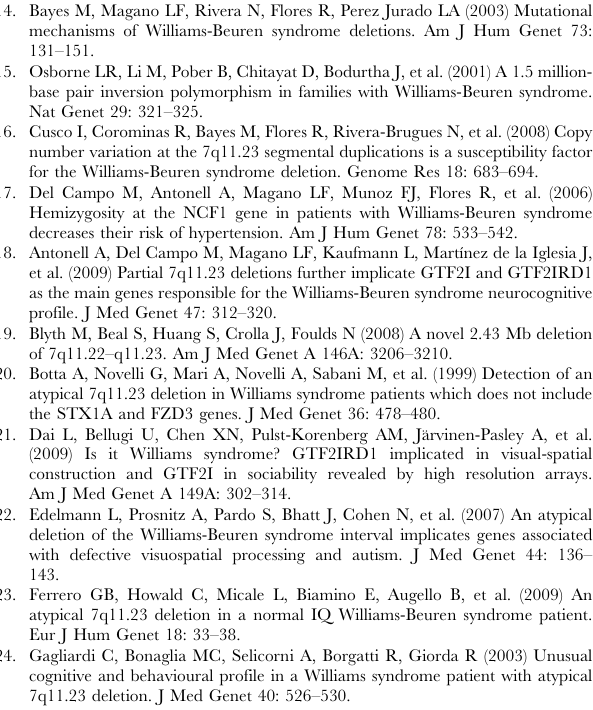
Table S6 GO/KEGG term enrichment in dysregulated M1 modules. Table S7 Dysregulated modules, M2. Table S8 GO/KEGG term enrichment in dysregulated M2 modules. Table S9 Most frequently occurring genes among dysregulated M1 and M2 modules. Table S10 GO/KEGG term enrichment among genes common to both sets of dysregulated modules. Table S11 Dysregulated single genes and modules common to fibroblasts and lymphoblastoid cell lines. Table S12 Software packages used for the